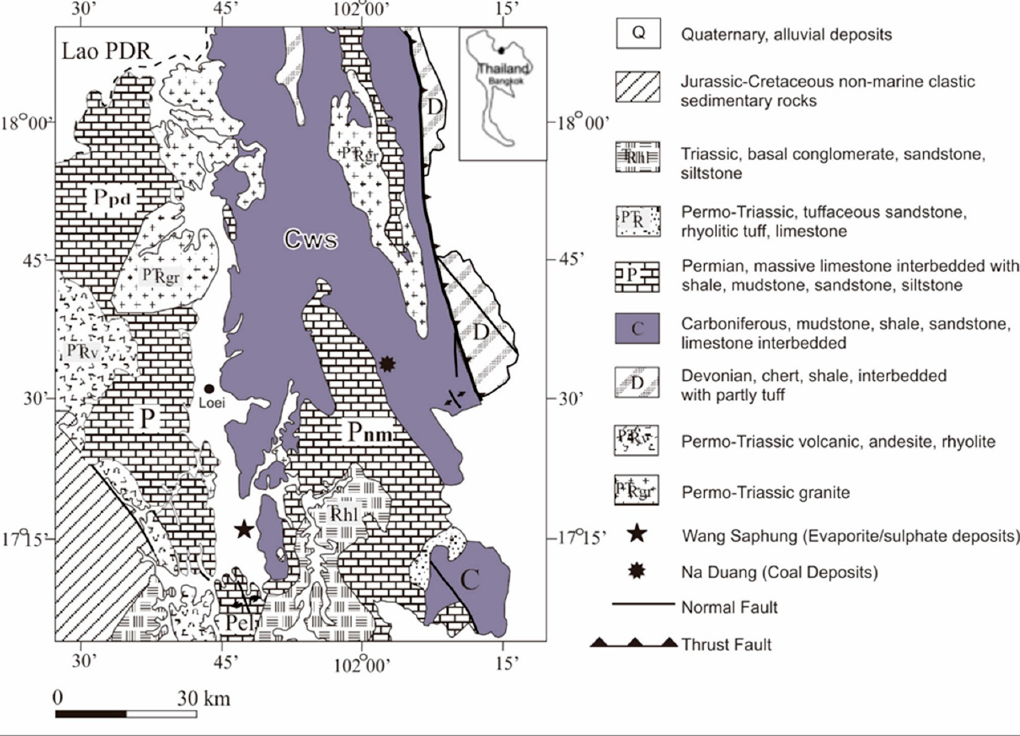
Figure 1. Geological map showing the locations of the Loei-Wang Saphung area (LWS) evaporate/sulfate deposits in the Loei Province, northeastern Thailand (modified after Department of Mineral Resources of Thailand (DMR), 2005) [3].